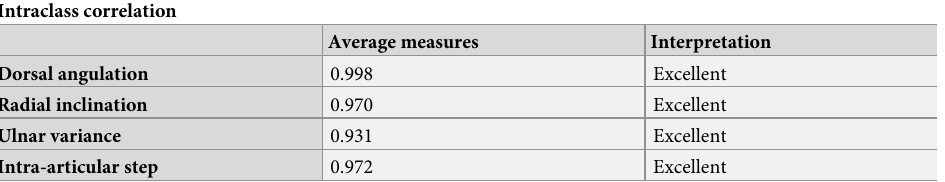
Table 2. Interrater reliability was measured between three raters with intraclass correlation coefficient in a retro- spective cohort study of 1,635 DRFs in two hospitals in Sweden from 2014–2017. Measures < 0.50 are